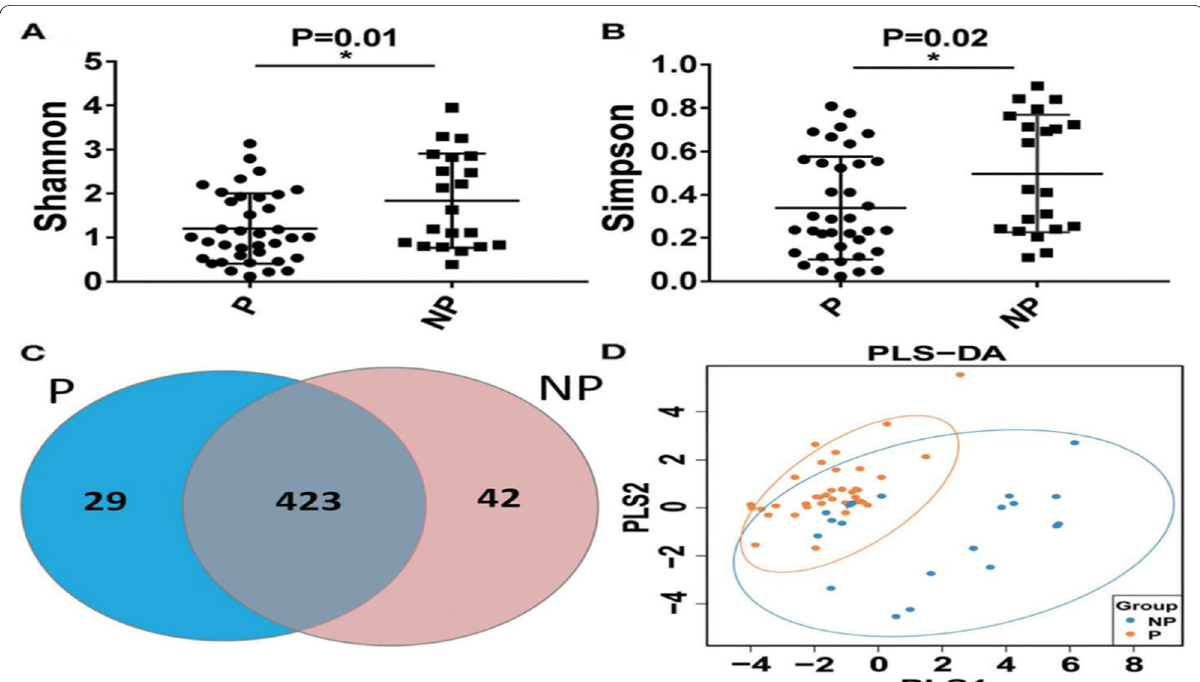
Fig. 3 In the P and NP groups, alpha-diversity and comparative study of bacterial diversity were performed. The Shannon index ( A ), the Simpson index, ( B ) the Scalar-Venn, ( C ) the PLS-DA ( D ). P, pregnancy success after embryo transfer; NP, pregnancy failure after embryo transfer; *means P < 0.05, p < 0.05 which indicates significant